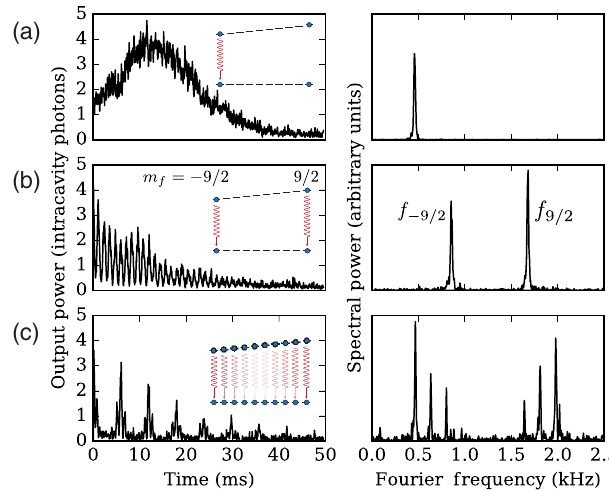
FIG. 2. Superradiant pulses in the time and frequency domains with different initial nuclear spin state populations. Atomic state population is initialized (a) with all atoms in a single stretched state, (b) with atoms in both stretched states, and (c) with all ten spin states populated. Columns represent the output power measured in the time domain (left), the initial spin state population (inset), and power spectrum of output power measured relative to a stable reference laser up to an arbitrary frequency offset (right), for single trials of the experiment. In the frequency domain, we observe a single peak in the power spectrum when we populate only one stretched state, two peaks when we populate both stretched states, and many peaks when we populate all ten Zeeman